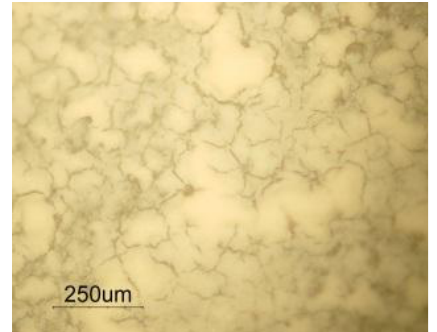
Figure 3: Optical micrograph view of